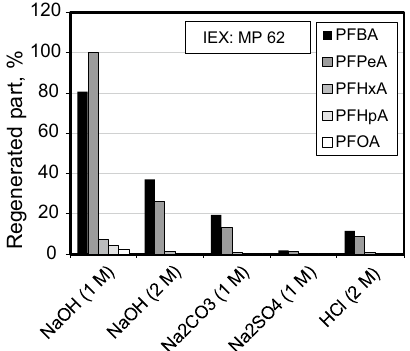
Fig. 9 Regenerated PFCA content using different regeneration agents